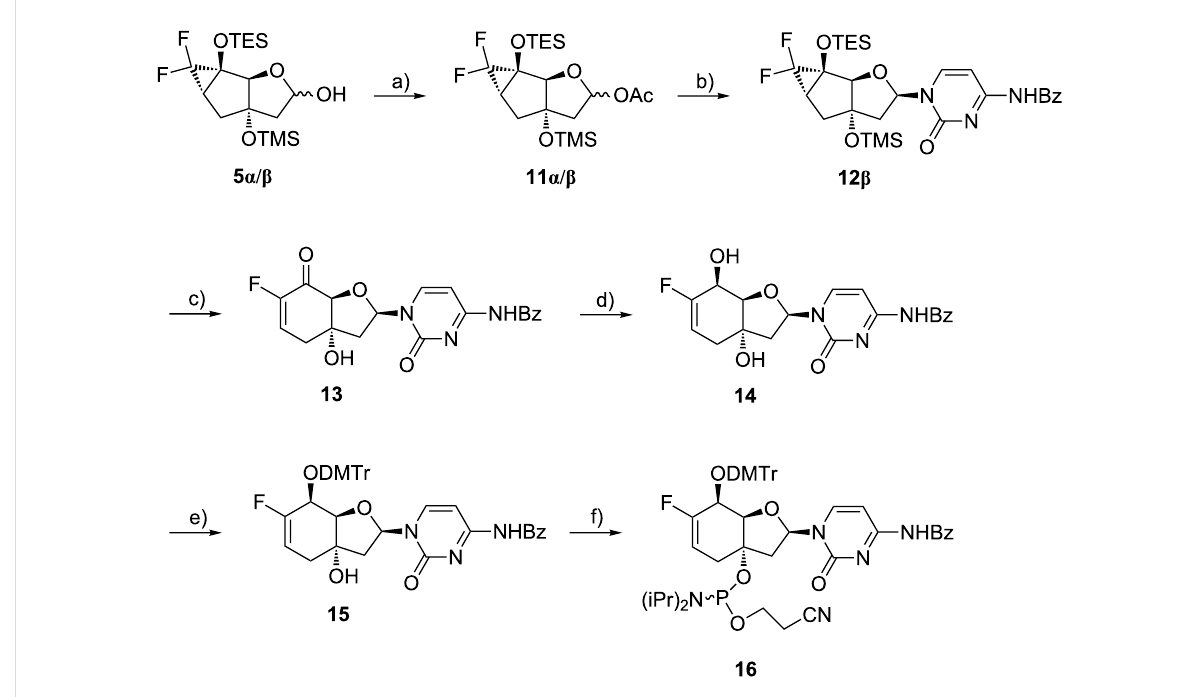
Scheme 3: Synthesis of the cytidine phosphoramidite building block 16 . Reagents and conditions: a) Ac 2 O, pyridine, 0 °C to rt, 17 h, 87%; b) N -benzoylcytosine, BSA, TMSOTf, ACN, 0 °C to rt, 3.5 h, 41%; c) HF-pyridine, DCM/pyridine 5:1, 0 °C, 15 min, 91%; d) i) CeCl 3 ·7H 2 O, NaBH 4 , MeOH, − 78 °C, 20 min; ii) Bz 2 O, DMF, rt, 7 h, 94%; e) DMTr-OTf, DCM/pyridine 1:2, rt, 19.5 h, 44%; f) CEP-Cl, DIPEA, THF, rt, 75 min,